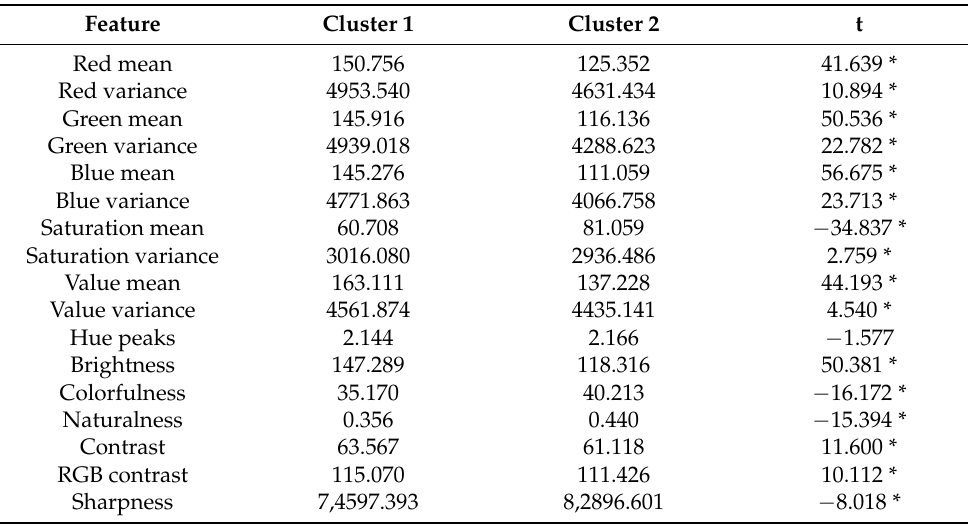
Table 3. The mean comparison of pixel-level features between clusters of the Instagram photos with a #NoMask